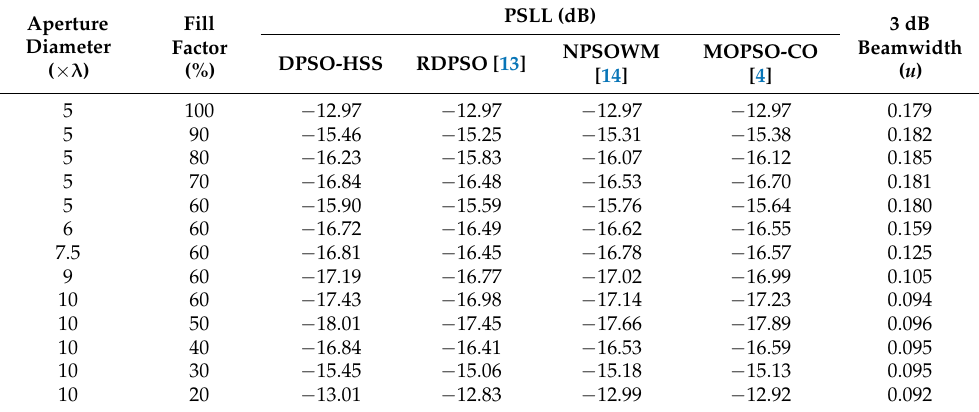
Table 3. Synthesis results obtained by four algorithms for large planar thinned arrays.